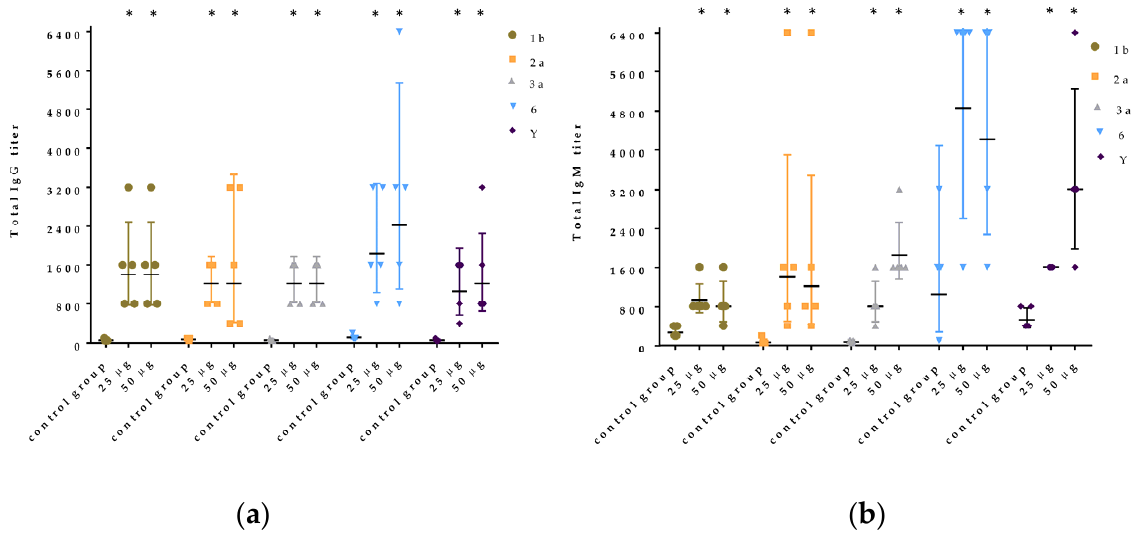
Figure 5. Immunogenicity in mice of individual components of PLVF—five Ac 3 -S-LPSs from S. flexneri 1b, 2a, 3a, Y, and 6. ( a ) Total IgG responses after vaccination with a dose of 25 or 50 μ g, ( b ) IgM responses after vaccination with a dose of 25 or 50 μ g. Results shown as mean ± SD. Significant difference between control and experimental group values is indicated (* p < 0.05). In the group of mice immunized with PLVF, an increase in the titer of specific IgG antibodies was also observed ( p ≤ 0.05). Titers of IgG to LPS S. flexneri 1b, 2a, 3a, Y, and 6 were 1213 ± 438, 1393 ± 980, 1056 ± 438, 2786 ± 2629, and 1600 ± 2360, respectively (Figure 6a).